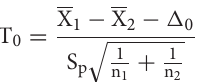
sample sizes. The test statistic T 0 has a t-distribution with (n 1